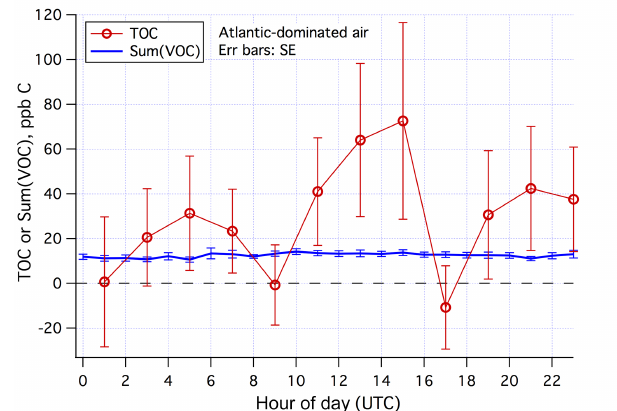
Figure 10. Averaged diurnal cycles in Sum(VOC) and estimated TOC in Atlantic-dominated air masses and during weekends– holidays. Error bars indicate standard